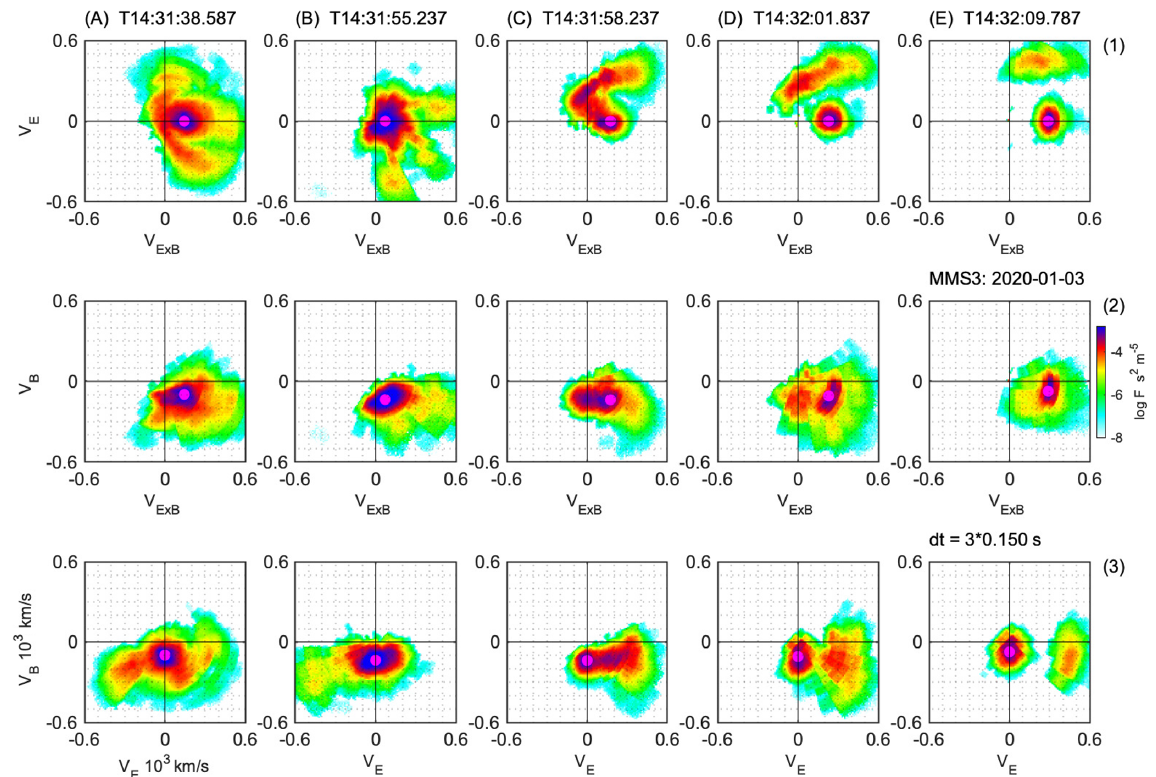
Figure 4. Ion distribution functions measured by the Fast Plasma Investigation (FPI) on MMS3 at times indicated in Fig. 2. The columns correspond to events A–E and show three projections of the ion distribution function. The first row shows a reduced two-dimensional distribution function in the perpendicular plane F(v E × B ,v E ) , the second row shows F(v B ,v E × B ) , and the third row shows F(v B ,v E ) , integrated over the remaining velocity. Magenta circles show positions of the primary beam. The distributions are averages of three sampling times of 0.15s